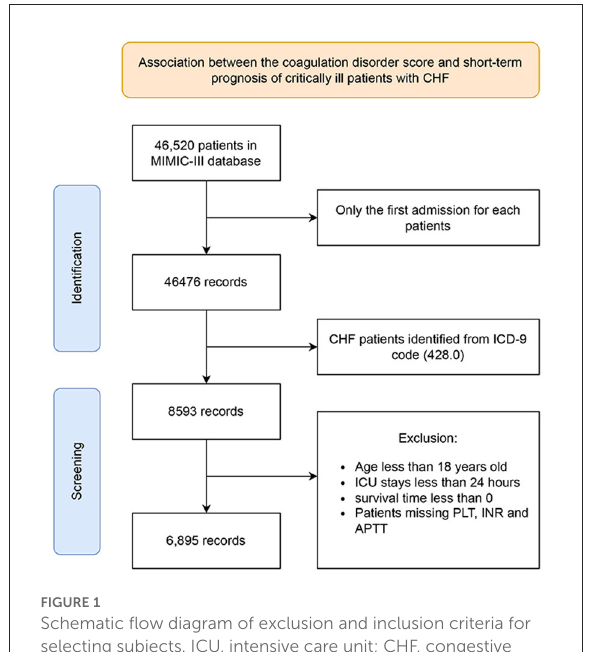
FIGURE1 Schematic flow diagram of exclusion and inclusion criteria for selecting subjects. ICU, intensive care unit; CHF, congestive heart failure; PLT, platelet; INR, international normalized ratio; APTT, activated partial thromboplastin